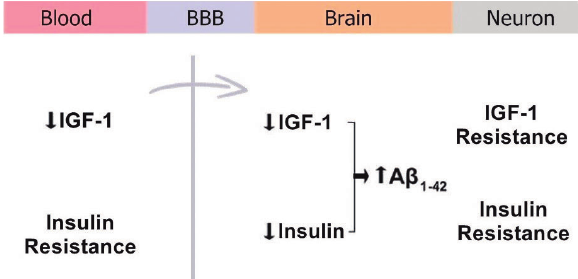
Figure 2. Uptake of IGF-1 and insulin into the brain. A reduction of IGF- 1 and peripheral insulin resistance promotes a reduction in uptake of IGF-1 and insulin into the brain, resulting in accumulation of A β . Neuro- nal insulin resistance contributes to A β accumulation because the insu- lin degrading enzyme (IDE) also degrades A β . BBB: Blood-brain barrier; IGF-1: Insulin-like growth factor-1; A β : β -amyloid.